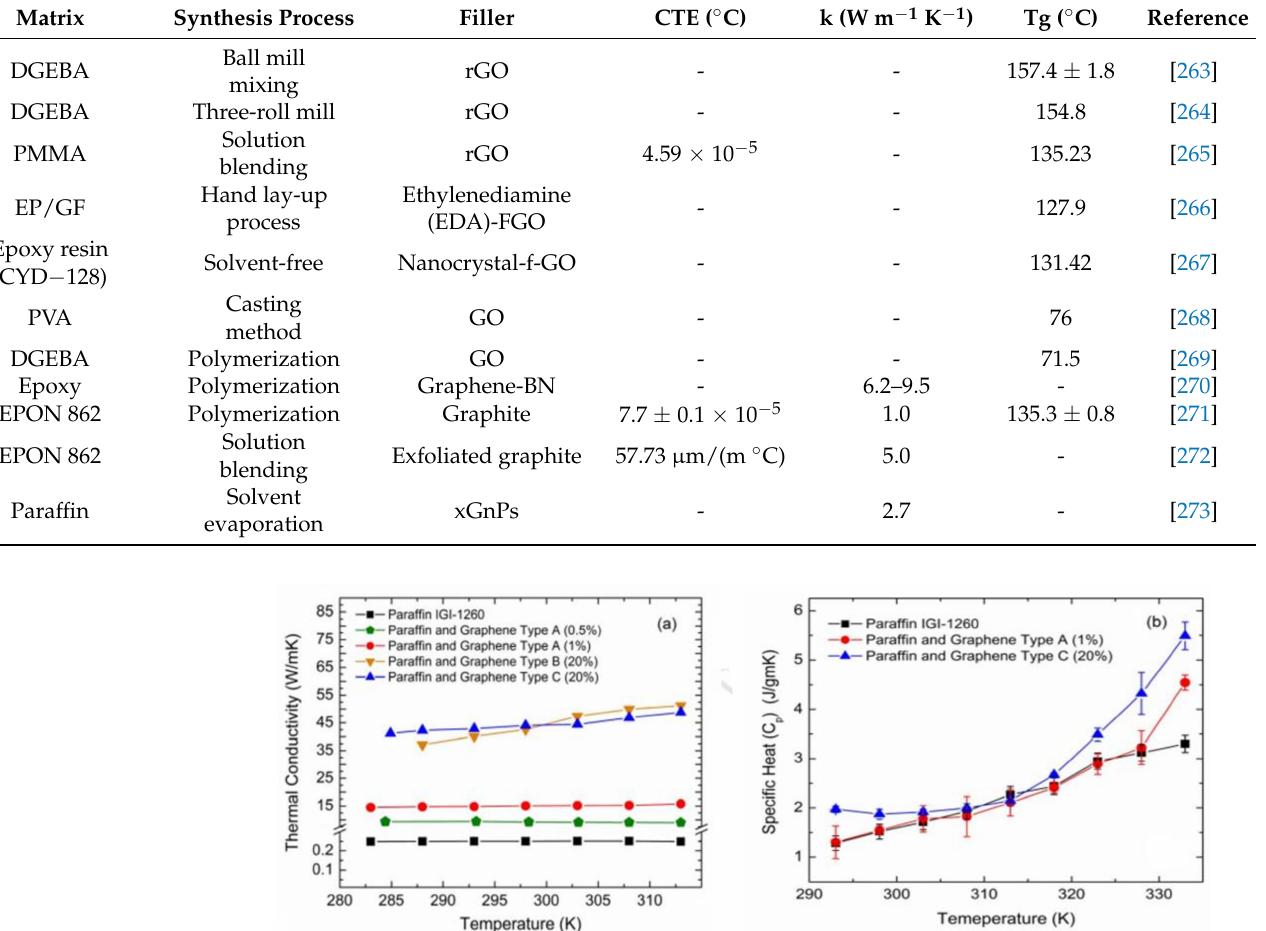
Table 3. Thermal characteristics of nanocomposites made of graphene and modified graphene.